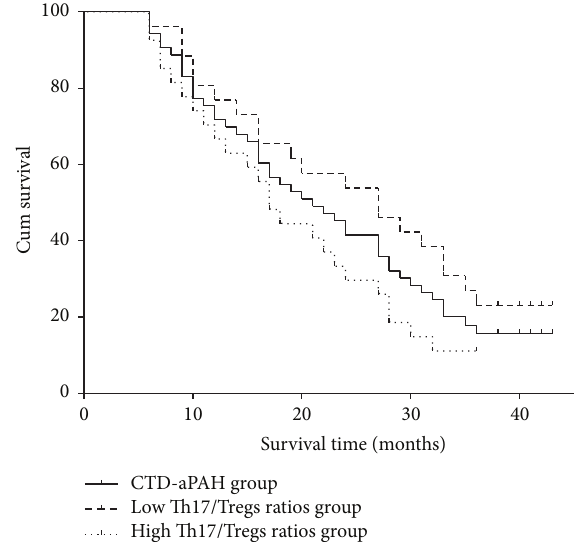
Figure 4: Kaplan-Meier survival analysis of patients with CTD- aPAH. Curves showed overall survival time for patients with CTD- aPAH who had lower or higher Th17/Treg